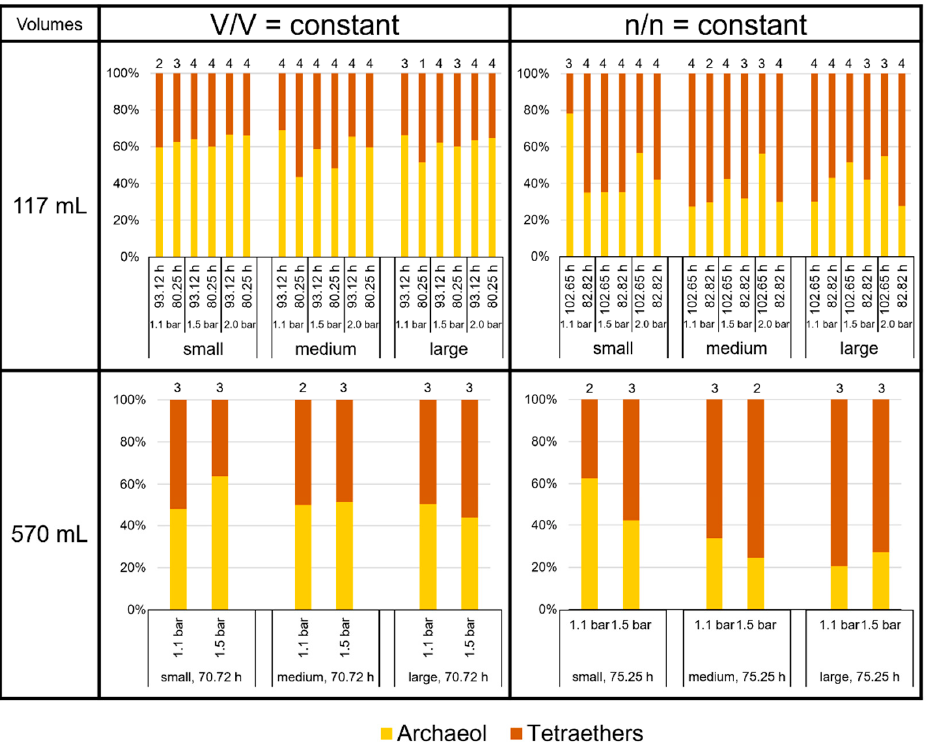
Figure 5. Lipid ratios of archaeol to tetraethers in M. marburgensis cultures in %. Pressure is given in bar relative to atmospheric pressure. Numbers above bars indicate number of samples. Samples quantified with 5- α -cholestane standard are indicated in Tables S4–S9.